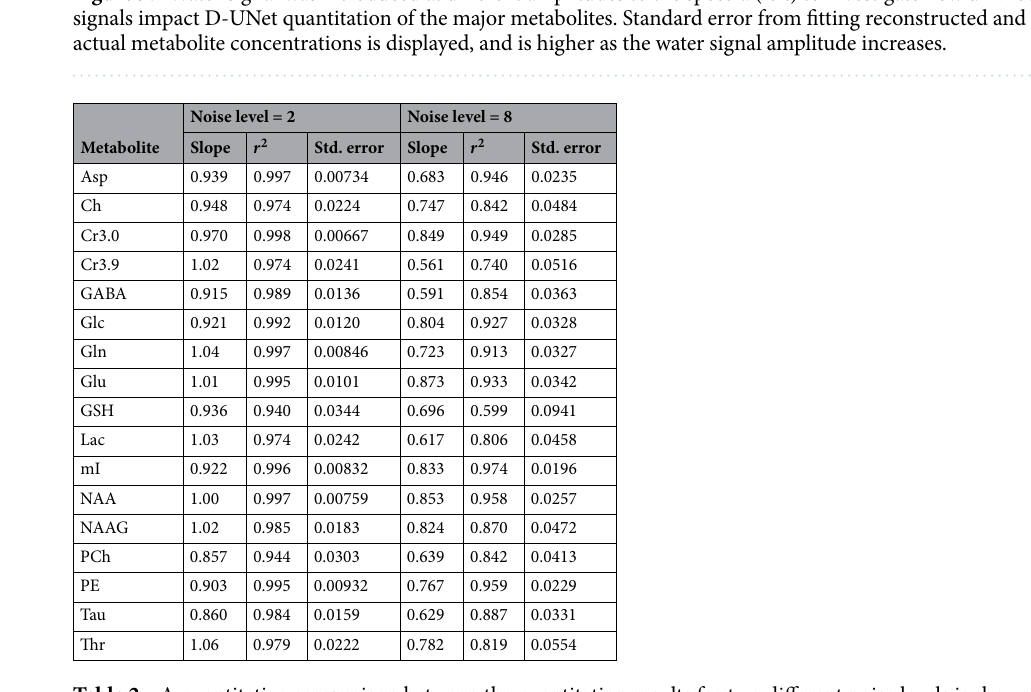
Table 2. A quantitative comparison between the quantitation results for two different noise levels is shown. A perfect quantitation algorithm would produce the following results: slope = 1, r 2 = 1, and standard error (Std. Error) = 0. From the results, it is clear that higher SNR spectra produce more accurate quantitative results.